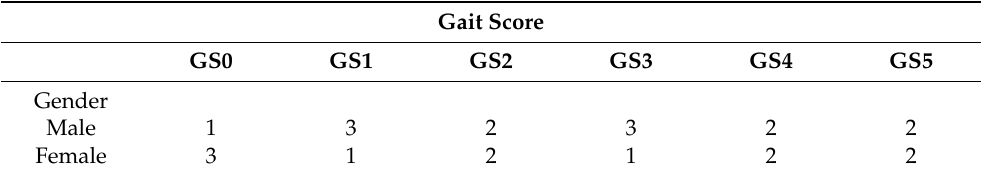
Table 1. The number of videotaped broilers used to analyze the walking velocity related to the gait score.